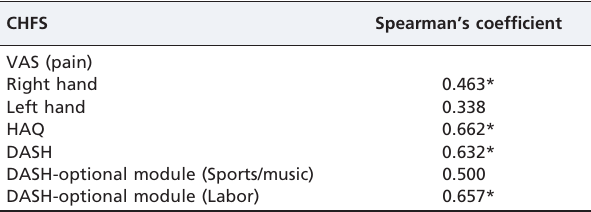
Table 4 - Evaluation of the correlations between the assessment tools and the Cochin Hand Functional Scale